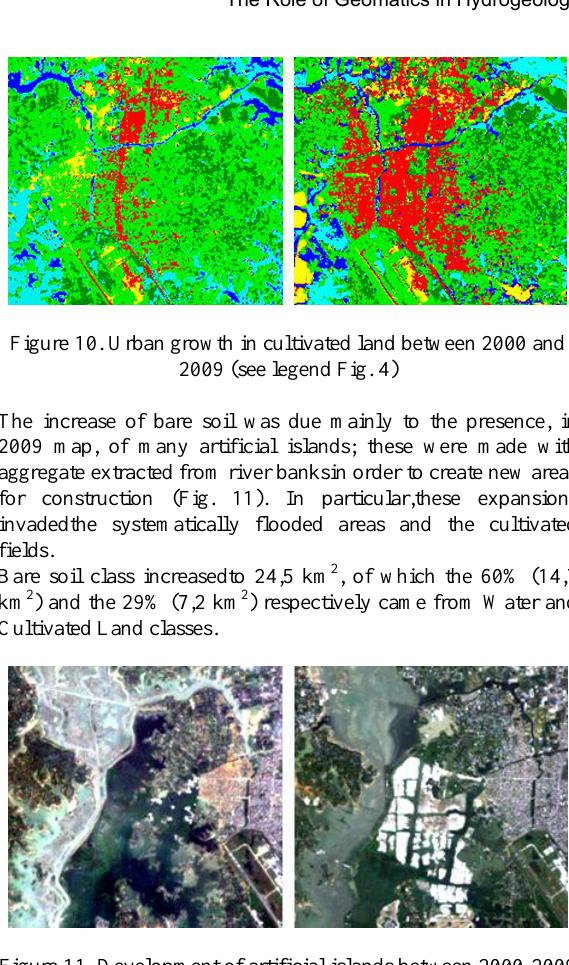
Figure 11. Development of artificial islands between 2000-2009